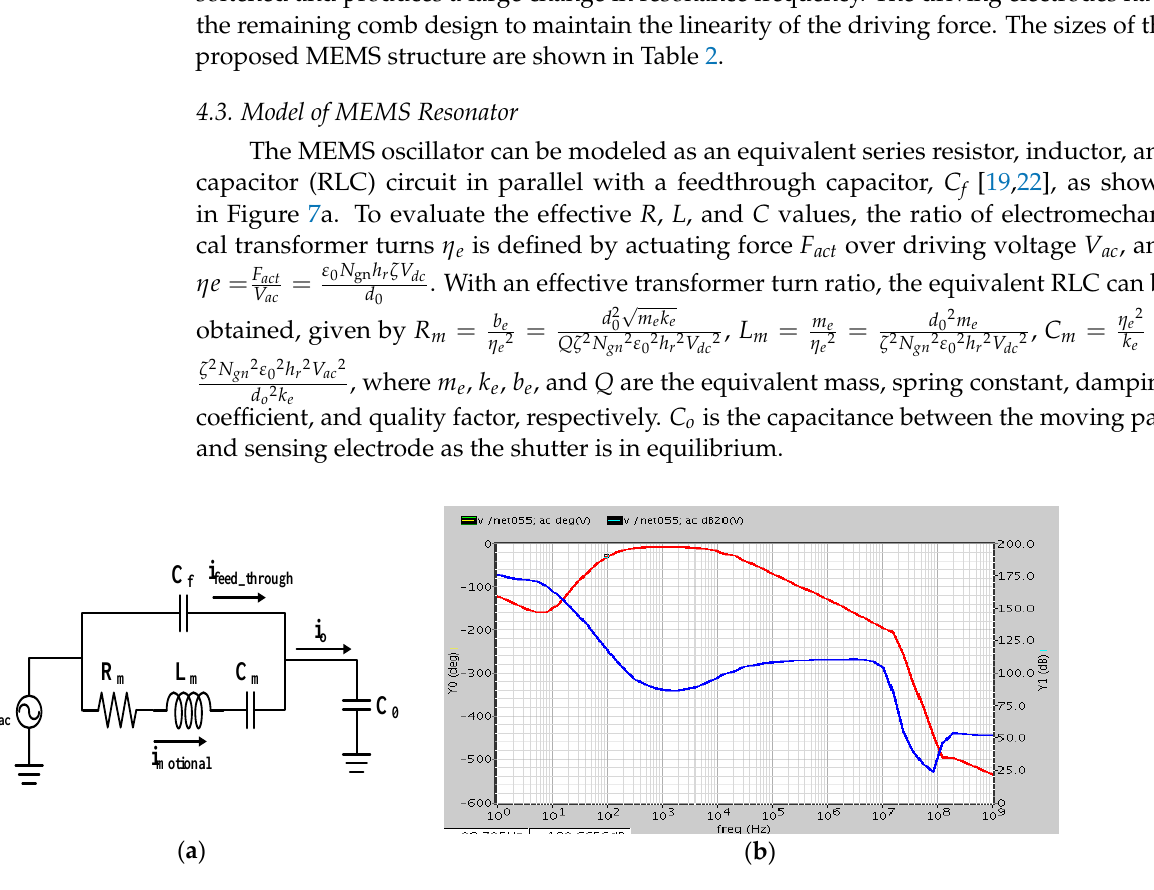
Figure 7. ( a ) Equivalent resistor, inductor, capacitor (RLC) model of MEMS oscillator; ( b ) Bode plot of loop gain and phase with large feedthrough capacitance.